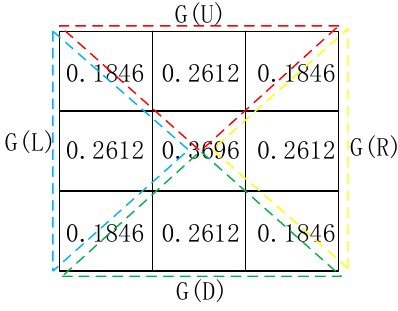
Figure 9. Final filtering parameters.